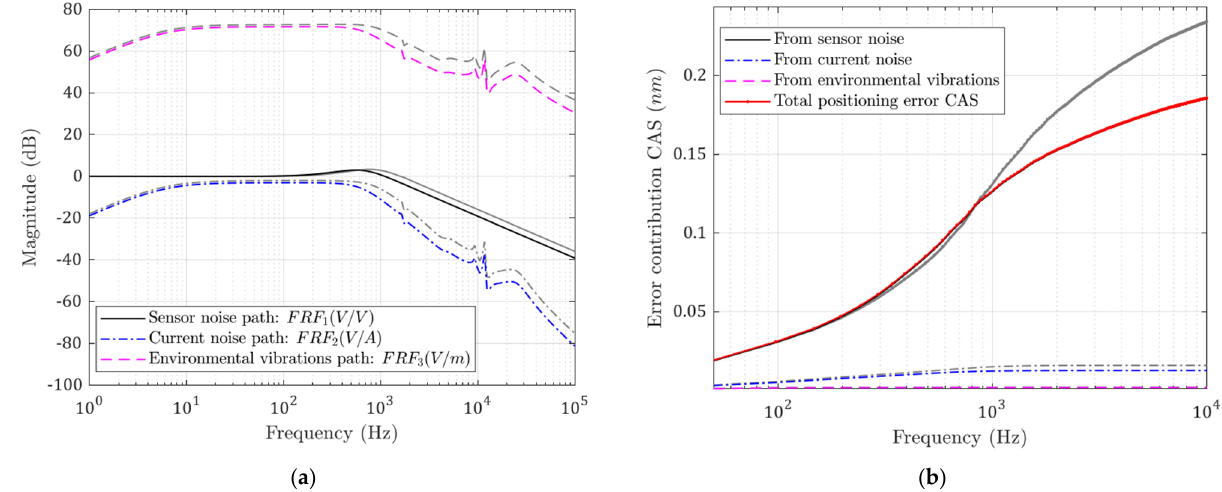
Figure 10. ( a ) Noise transfer functions; ( b ) CAS plots for each error source. Performance with increased moving mass (grey: before; colored: after).